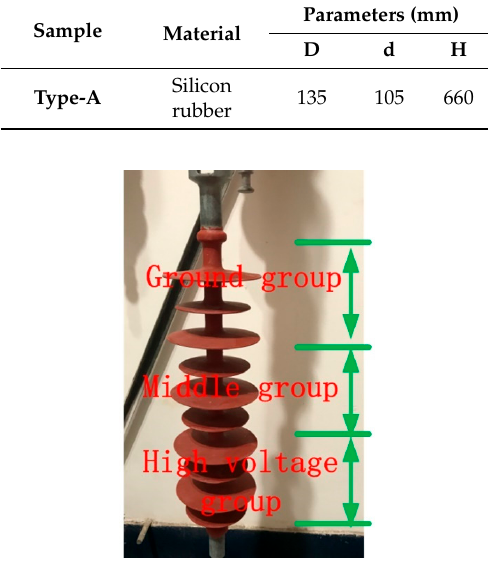
Figure 4. Structure of the samples.